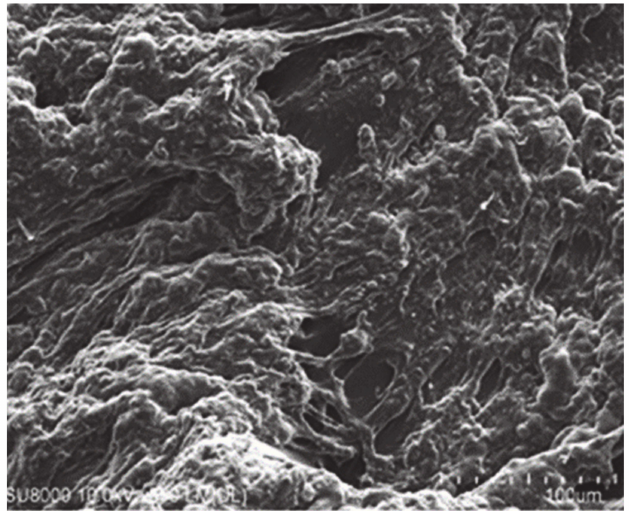
Figure 5. Surface morphology of SA-co-poly(AMPS)